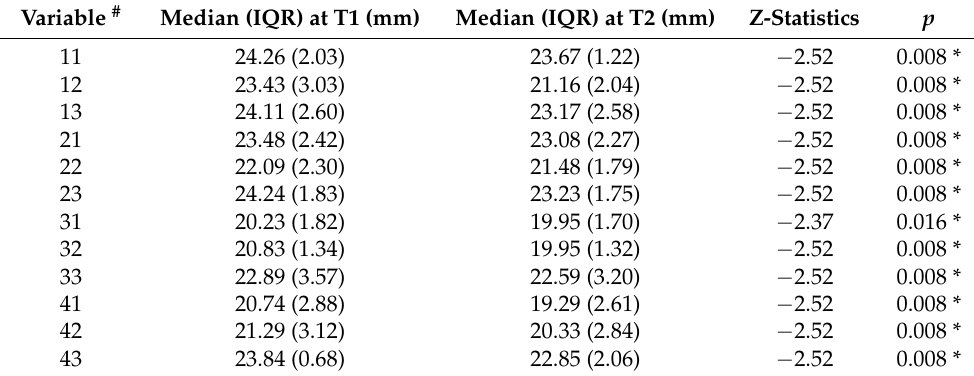
Table 2. Tooth length (root length and crown length) changes in CBL group.